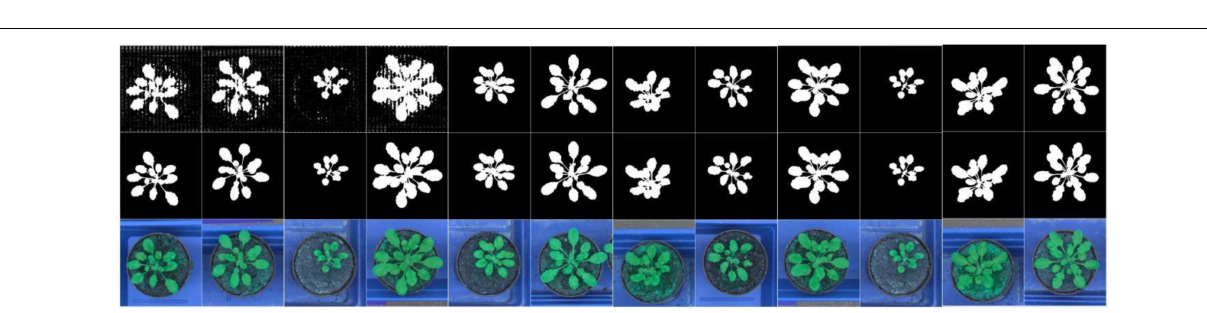
Frontiers in Plant Science |